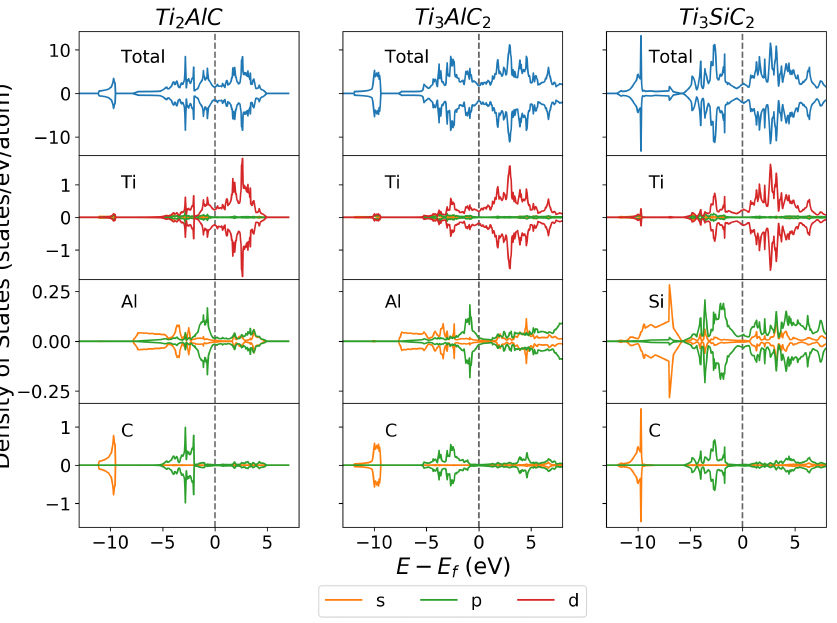
Figure 1. Element and orbital resolved density of states for Ti 2 AlC, Ti 3 AlC 2 and Ti 3 SiC 2 . The Fermi level is shown by the black dashed